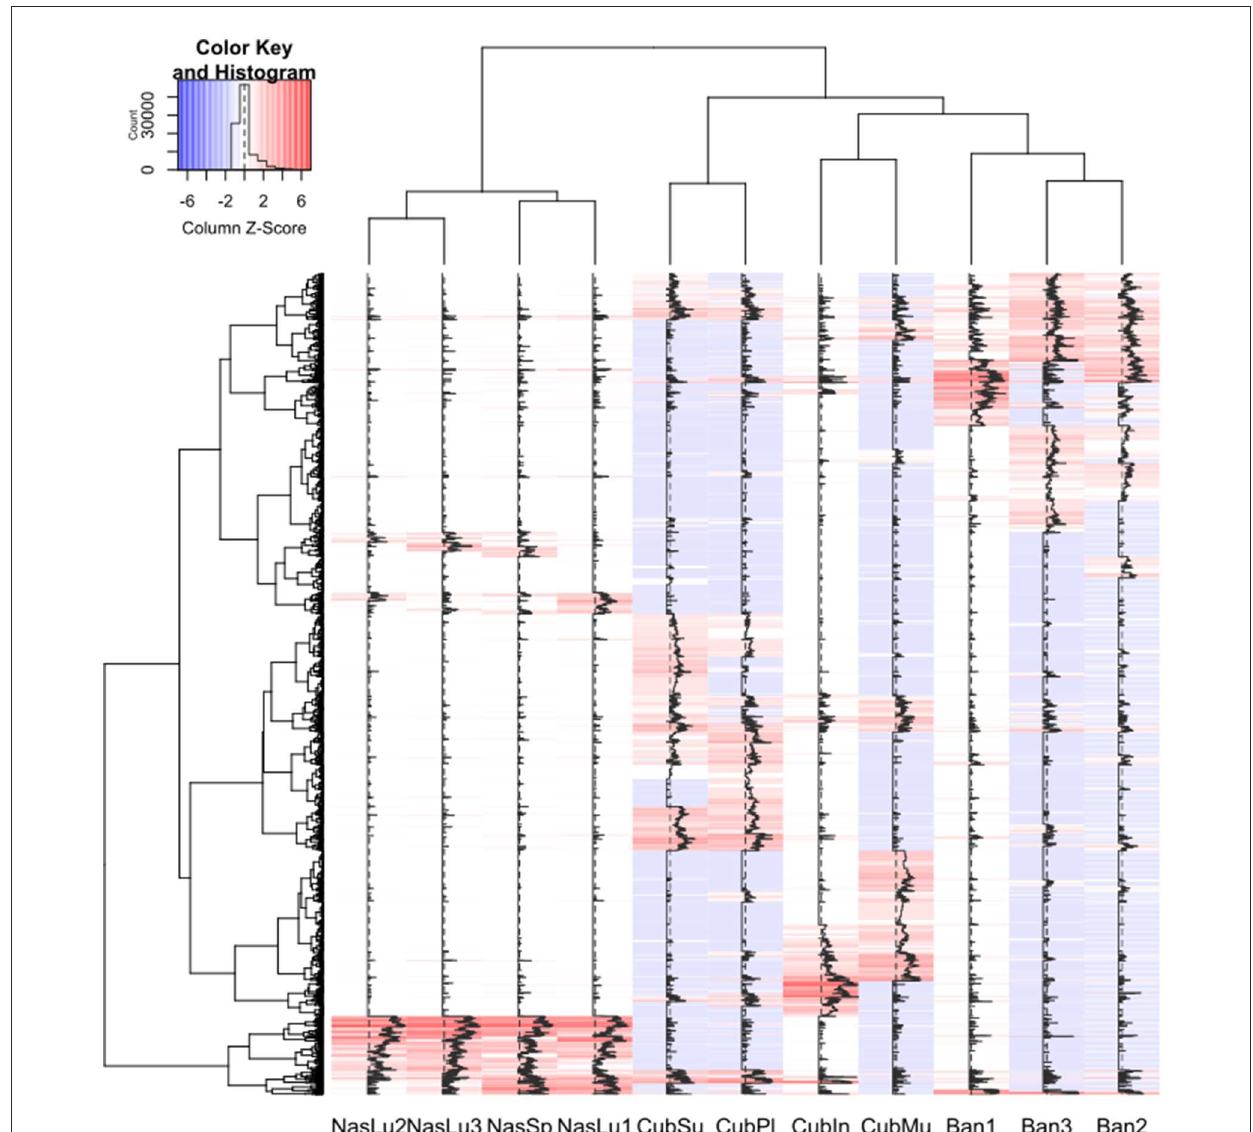
FIGURE10 Heatmap of genetic content profiles for the Aromadeg annotation set. Samples or genes clustered using Euclidean distance. Ban, Anoplotermes banksi ; CubIn, Cubitermes inclitus ; CubMu, Cubitermes muneris ; CubPl, Cubitermes planifrons ; CubSu, Cubitermes sulcifrons ; NasLu, Nasutitermes lujae ; Nassp, Nasutitermes sp. Numbers after sample name indicate replicate